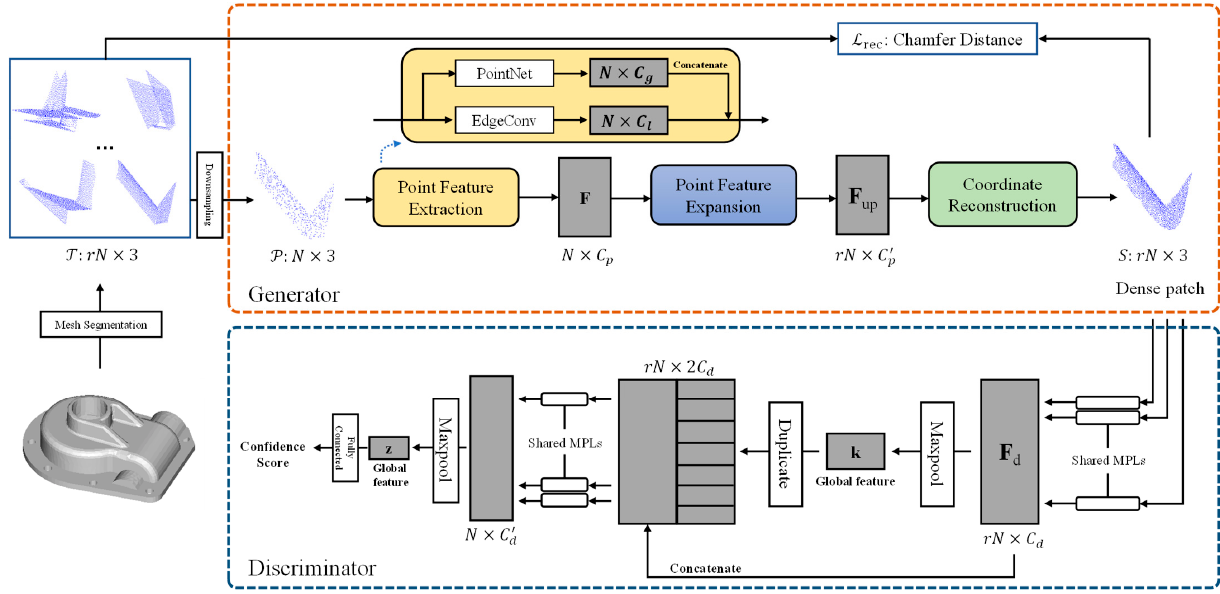
Figure 1. The architecture of the proposed upsampling network. Note that N is the number of points in input patch P , r is the upsampling rate, and C g , C l , C p , C (cid:48) p , C d , and C (cid:48) are the numbers of feature channels. Given a sparse input patch P with N points, we generate a dense patch S with rN points in the generator, which consists of feature extraction, feature expansion, and coordinate reconstruction. The goal of the discriminator is to distinguish whether its input is produced by the generator.